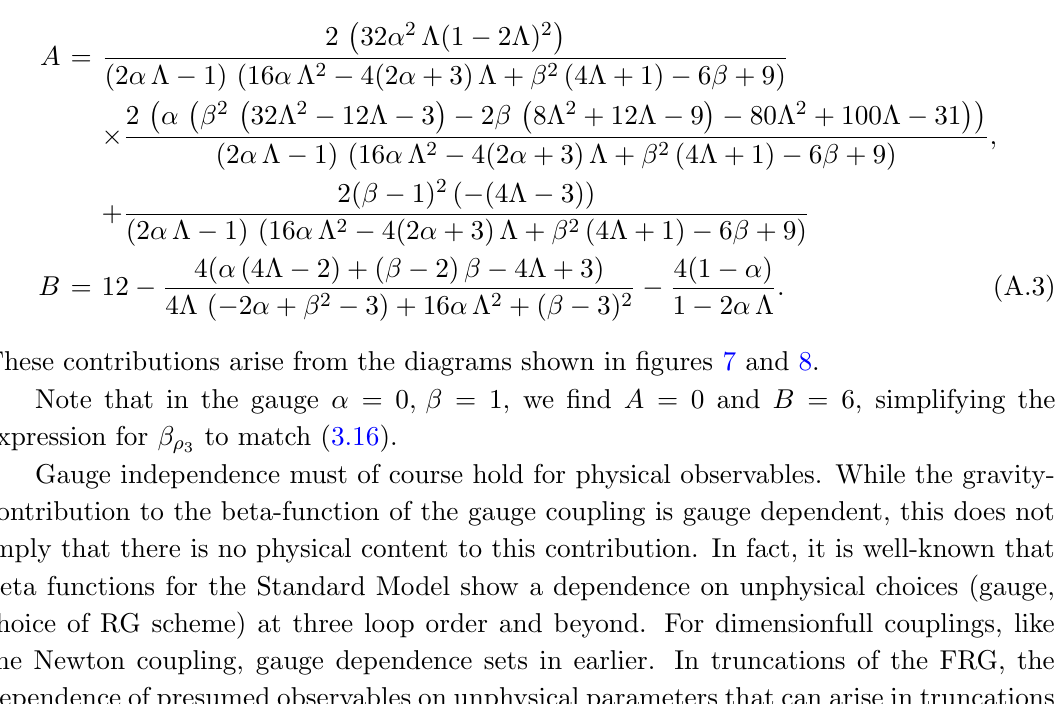
Figure 7 . We show the only diagram that contributes to (cid:12) (cid:26) Other diagrams with internal metric (cid:13)uctuations and the correct number of external legs vanish when projected onto (cid:26) 3 according to eq.